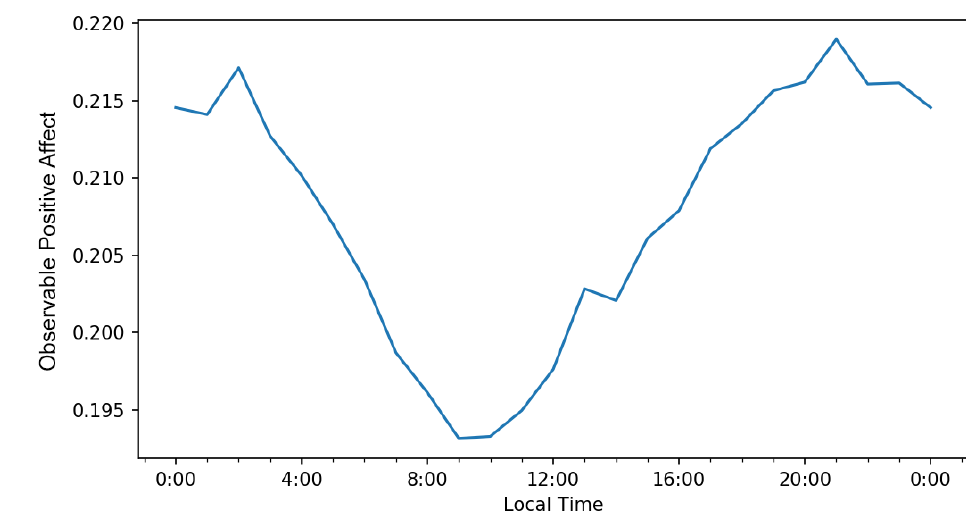
Figure 4. Daily patterns of observable PA in local time.